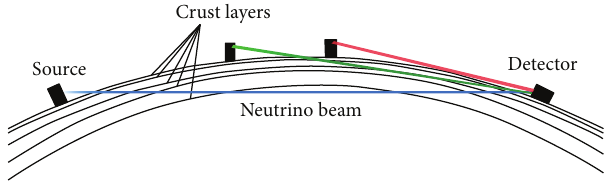
Figure 1: Simplified representation of the creation-detection neu- trino path, different cases generate different density maps.